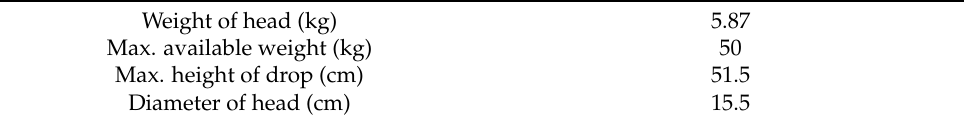
Figure 8. Drop weight test apparatus ( a ) and a bed sample prepared for the analyses ( b ). Table 4. Technical specifications of the drop-weight tester.